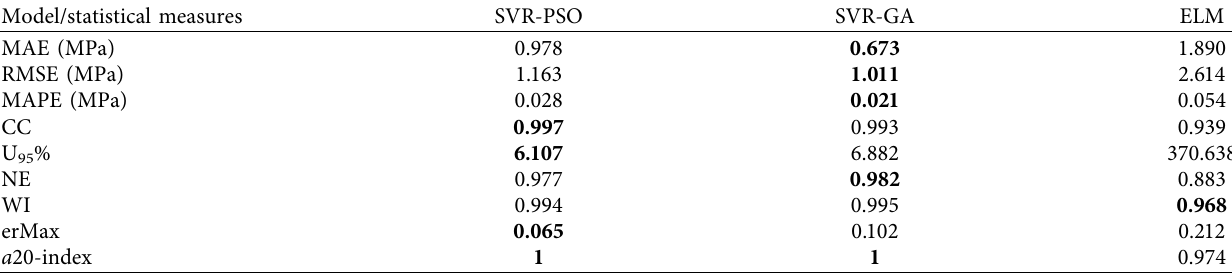
Table 2: Assessing the performance of each suggested model: training